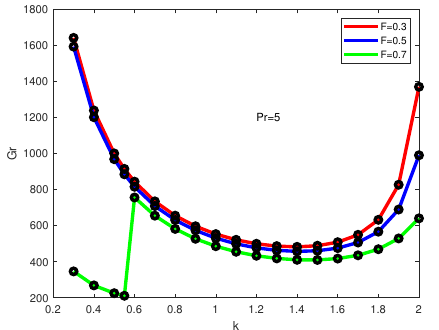
Figure 8. Marginal stability curves for Pr = 5 (Case 1).